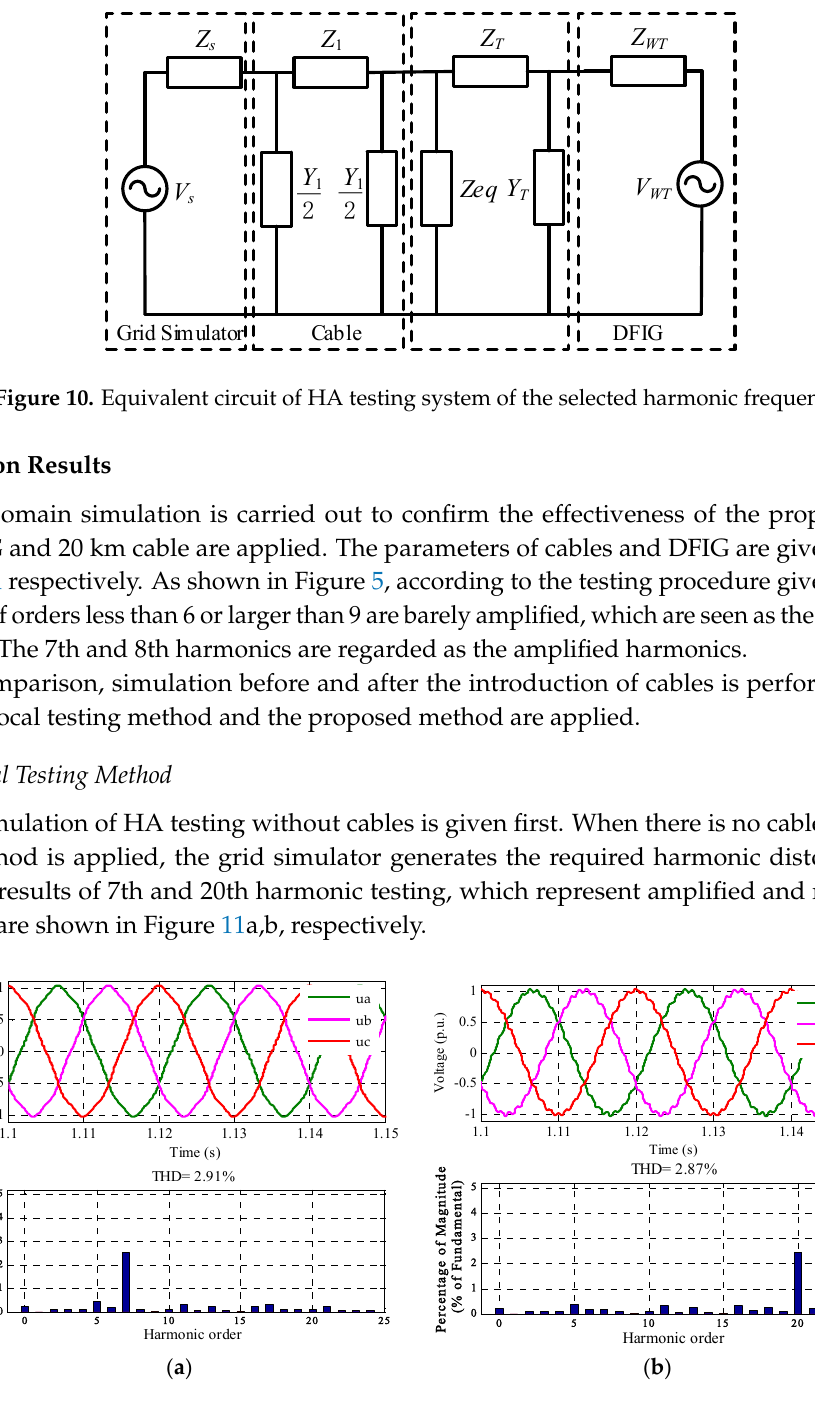
Figure 11. Simulation results without cables. ( a ) 3-phase voltage waveform and spectrum of 7th harmonic testing; ( b ) 3-phase voltage waveform and spectrum of 20th harmonic testing.